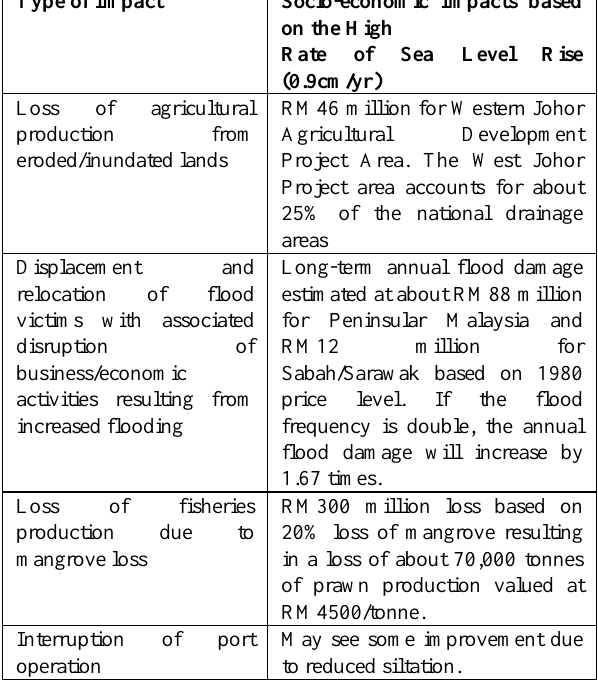
Table 3. The Socio-Economic Impacts Cause By Sea Level Rise